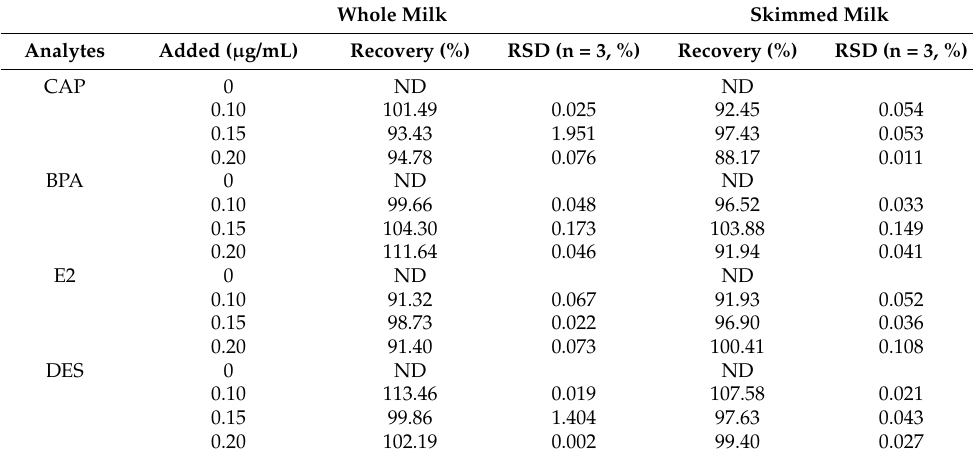
Table 1. Application and recoveries in milk sample.